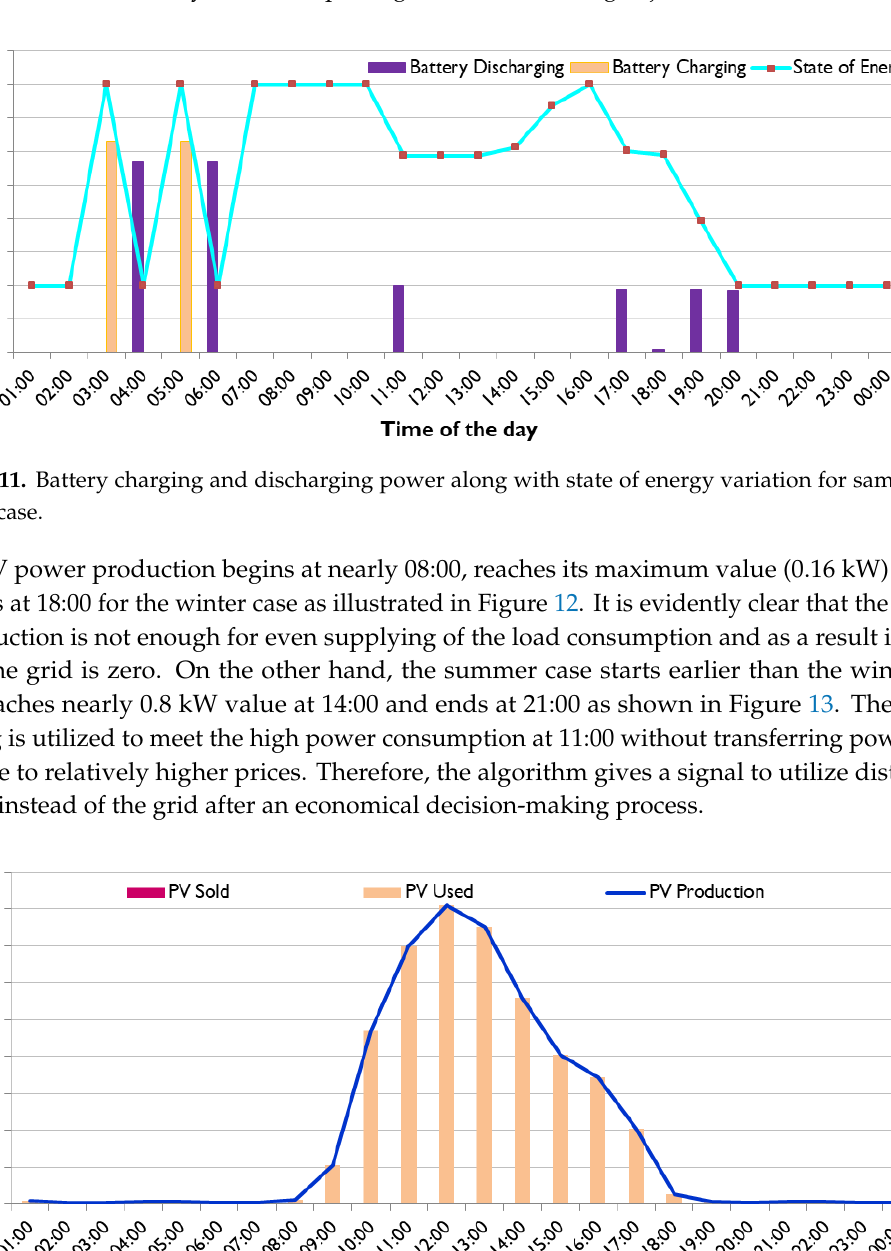
Figure 12. The PV system power decomposition for sample winter case.